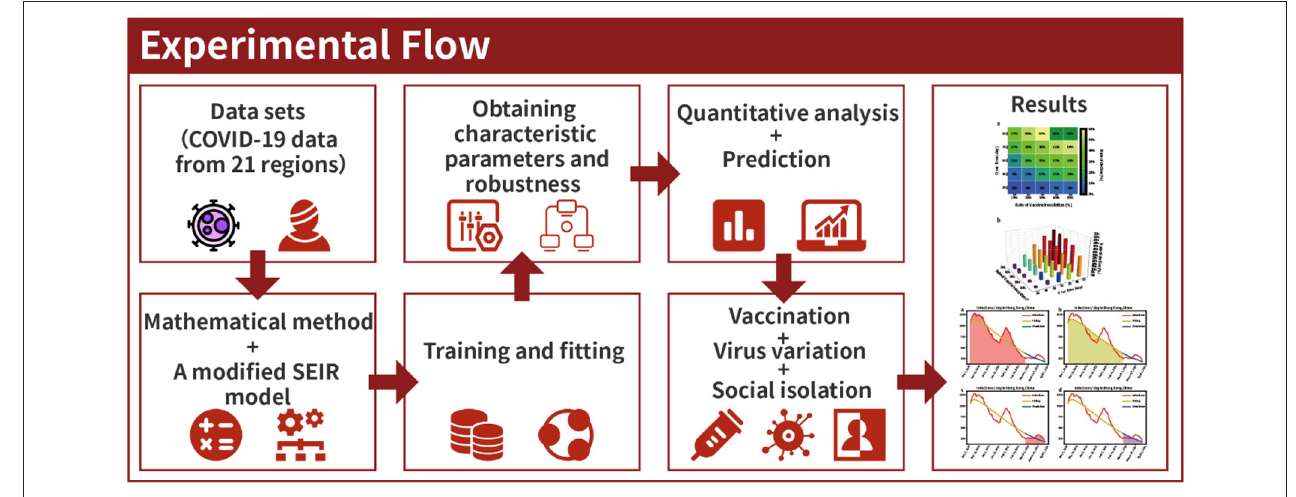
FIGURE 1 | Experimental